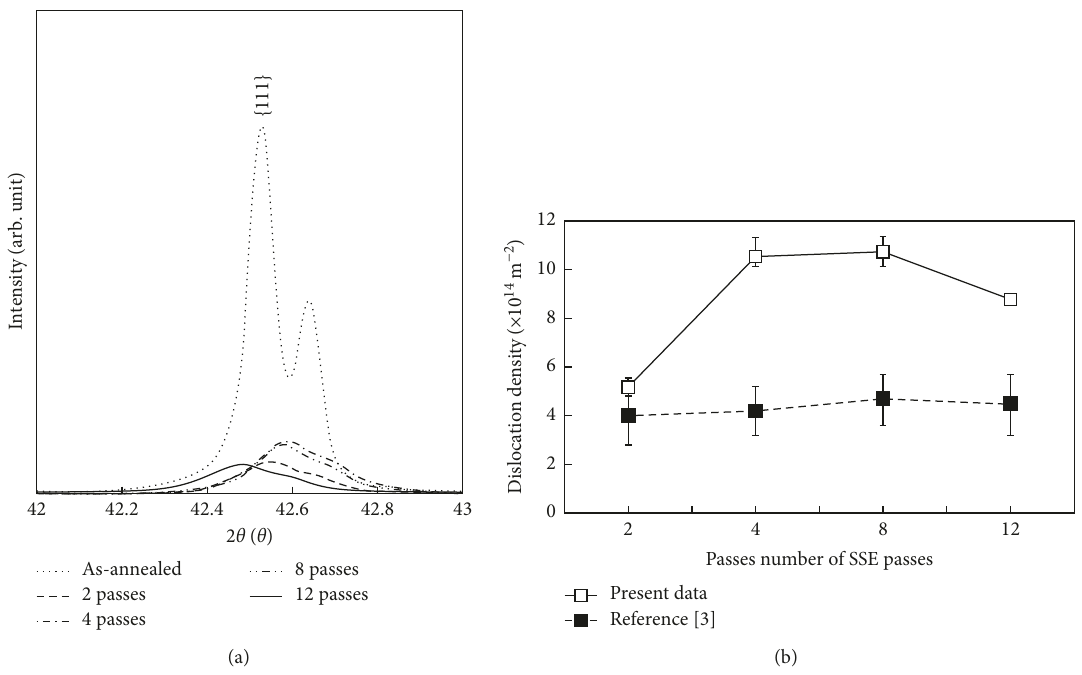
Figure 3: (a) {111} peaks of XRD patterns; (b) Dislocation density of SSE-processed sample by XRD.